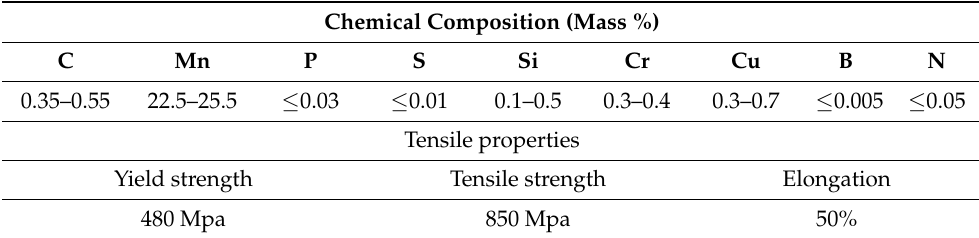
Table 1. Composition of high manganese steel.